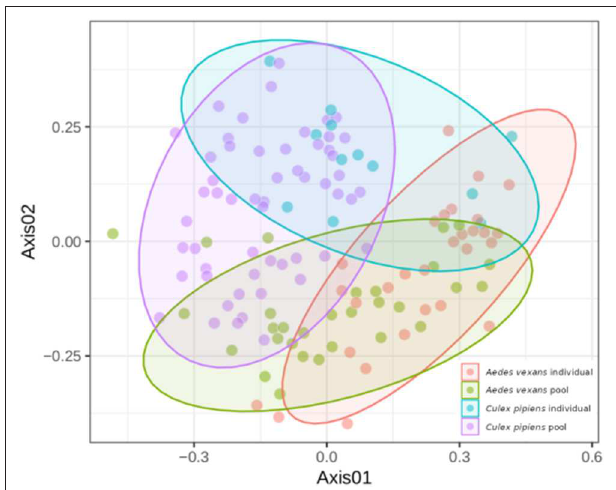
FIGURE 4 | NMDS showing the beta-diversity of Aedes vexans and Culex pipiens microbiomes both from individuals and pools. Confidence ellipses are shown for each group.